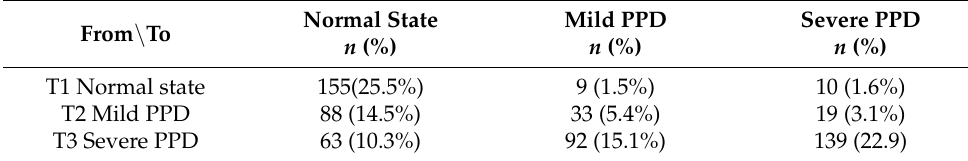
Table 2. Observed number of PPD transitions from one visit to the next